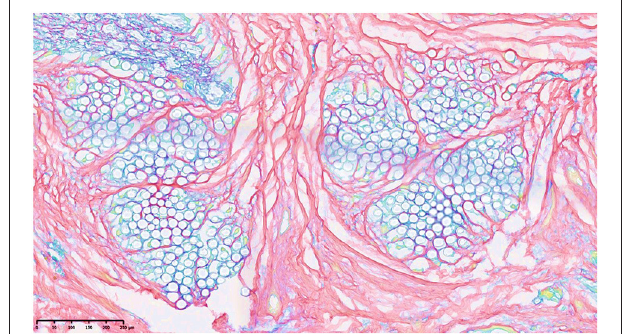
FIGURE 14 | Forming of collagen between 2 membranes in response to the integrated jacket of PCL (gray circles) showing the possibility of manipulation of collagen in tissue engineering. The stain is picrosirius